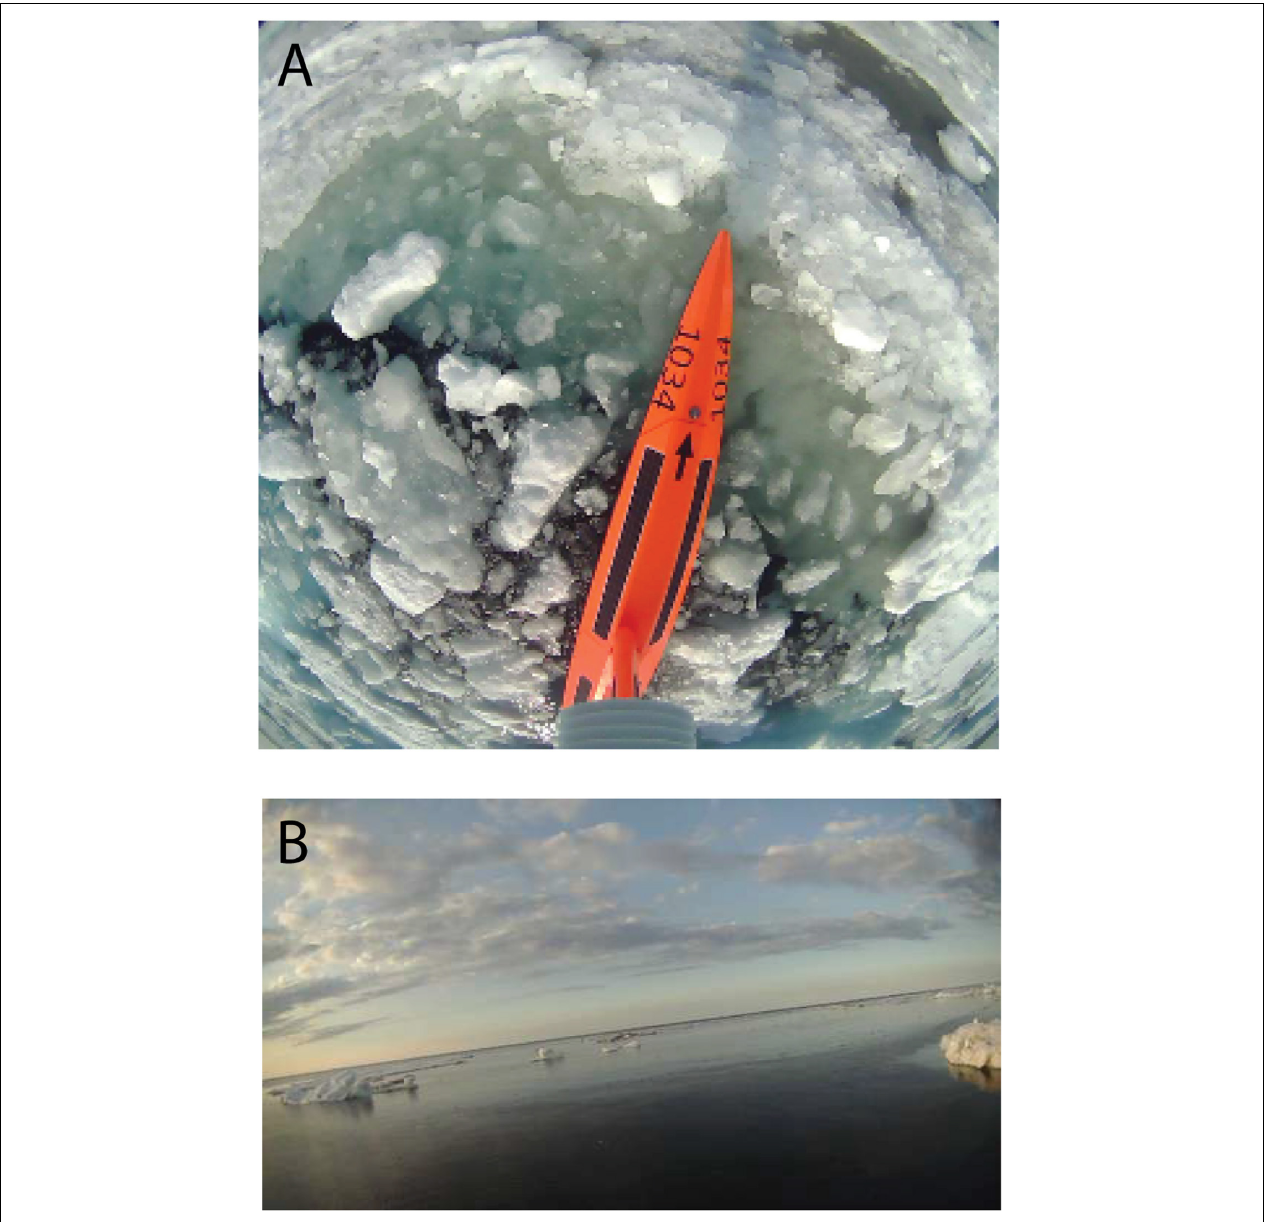
FIGURE 1 | Examples of (A) downward-looking image taken atop the saildrone wing while in sea ice, and (B) horizontal image from the saildrone wing with sea ice floes